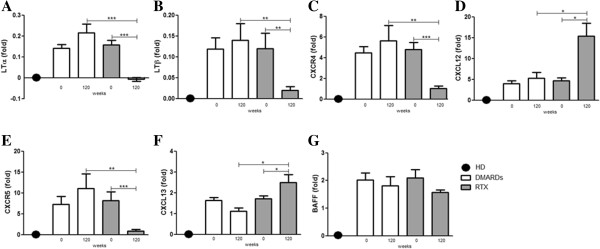
Molecular analysis of minor salivary gland biopsies in the rituximab and disease-modifying anti-rheumatic drug treatment groups. Relative mRNA quantification of (A) LTα, (B) LTβ, (C) CXCR4, (D) CXCL12, (E) CXCR5, (F) CXCL13, and (G) B-cell activating factor (BAFF) was assessed by quantitative real-time polymerase chain reaction in salivary glands obtained from 41 pSS patients and five healthy donors (HD). Bars indicate mean ± standard error of the mean. Levels are expressed as the fold increase or decrease in pSS MSGs compared with HD MSGs. ***P <0.001; **P <0.01 and *P <0.05. DMARD, disease-modifying anti-rheumatic drug; LT, lymphotoxin; RTX, rituximab.